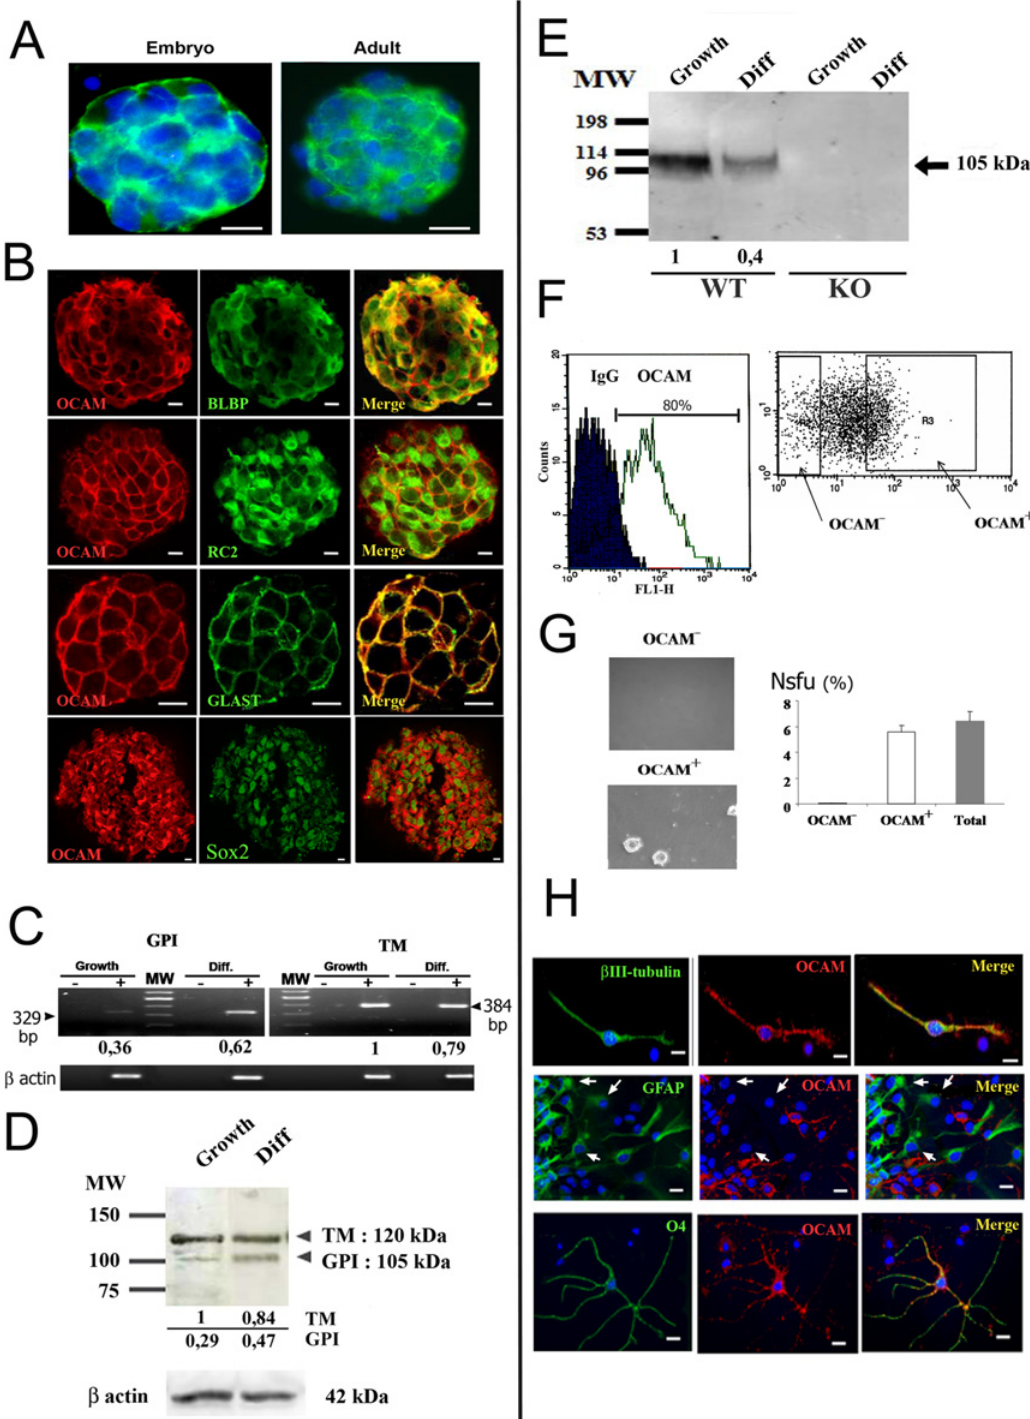
Fig 1. Expression of OCAM in spinal cord neural stem cells. ( A ): Detection by immunofluorescence of OCAM (green) in embryonic (left) and adult (right) spinal cord neurospheres. ( B ): OCAM is expressed by cells coexpressing BLBP, RC2, Sox2 and GLAST detected by immunofluorescence in embryonic spinal cord neurosphere cells (confocal images). A goat anti-OCAM antibody recognizing the external part of the protein was used for colabelling with BLBP, RC2 and GLAST whereas a rabbit antibody directed to the internal part of OCAM was used for labelling with anti Sox2 antibody. ( C ): PCR analysis of OCAM mRNA isoform expression in embryonic spinal cord neurospheres in growing condition (growth) or after 4 days of differentiation (diff.) Sizes (base pairs, bp)